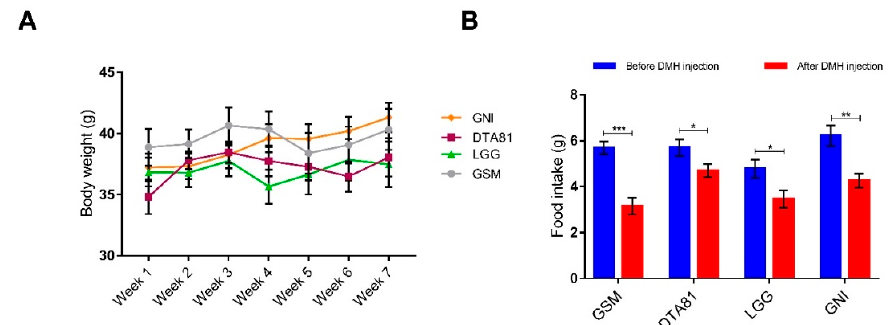
Figure 1. ( A ) Changes in BALB/c mice body weight during the experimental period in the control (skim milk, GSM, and non-intervention, GNI) and probiotic ( L. paracasei DTA81, and L. rhamnosus GG, LGG) groups. ( B ) Food intake was significantly reduced in all groups following 1,2- dimethylhydrazine (DMH) injection. Data represent the mean weight during the experimental period.